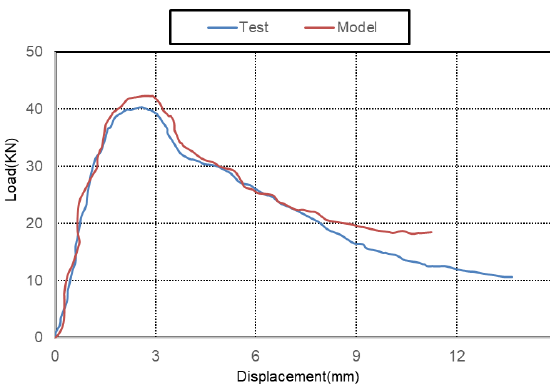
Figure 8: A comparison of the load-displacement curves Table 3: The details of developed models Model no.